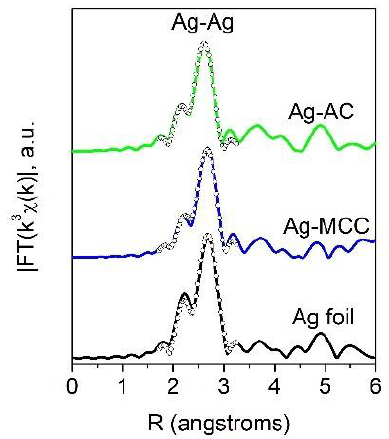
Figure 9. Fourier transforms of Ag K-edge EXAFS spectra for Ag-cellulose composites: experiment (solid lines) and best-fit (open circles).